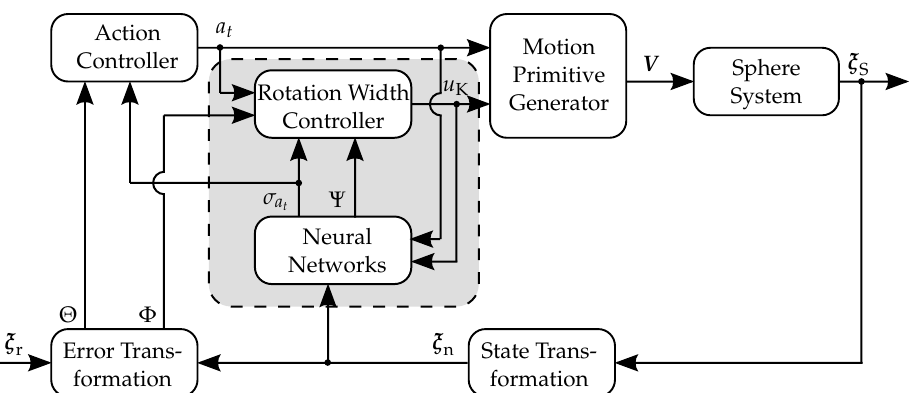
Figure 9. Block diagram of the basic control loop (white background) and an extension for higher precision (gray background). The measured sphere state ξ S is transformed into surface normal coordinates ξ n , and its deviation from the reference coordinates ξ r is transformed into angular errors Θ , Φ . The action controller then chooses a suitable action a t , based on which the motion primitive generator computes the corresponding input sequences V for the beam actuators. The extension consisting of neural networks and a rotation width controller enable an improved angular resolution.